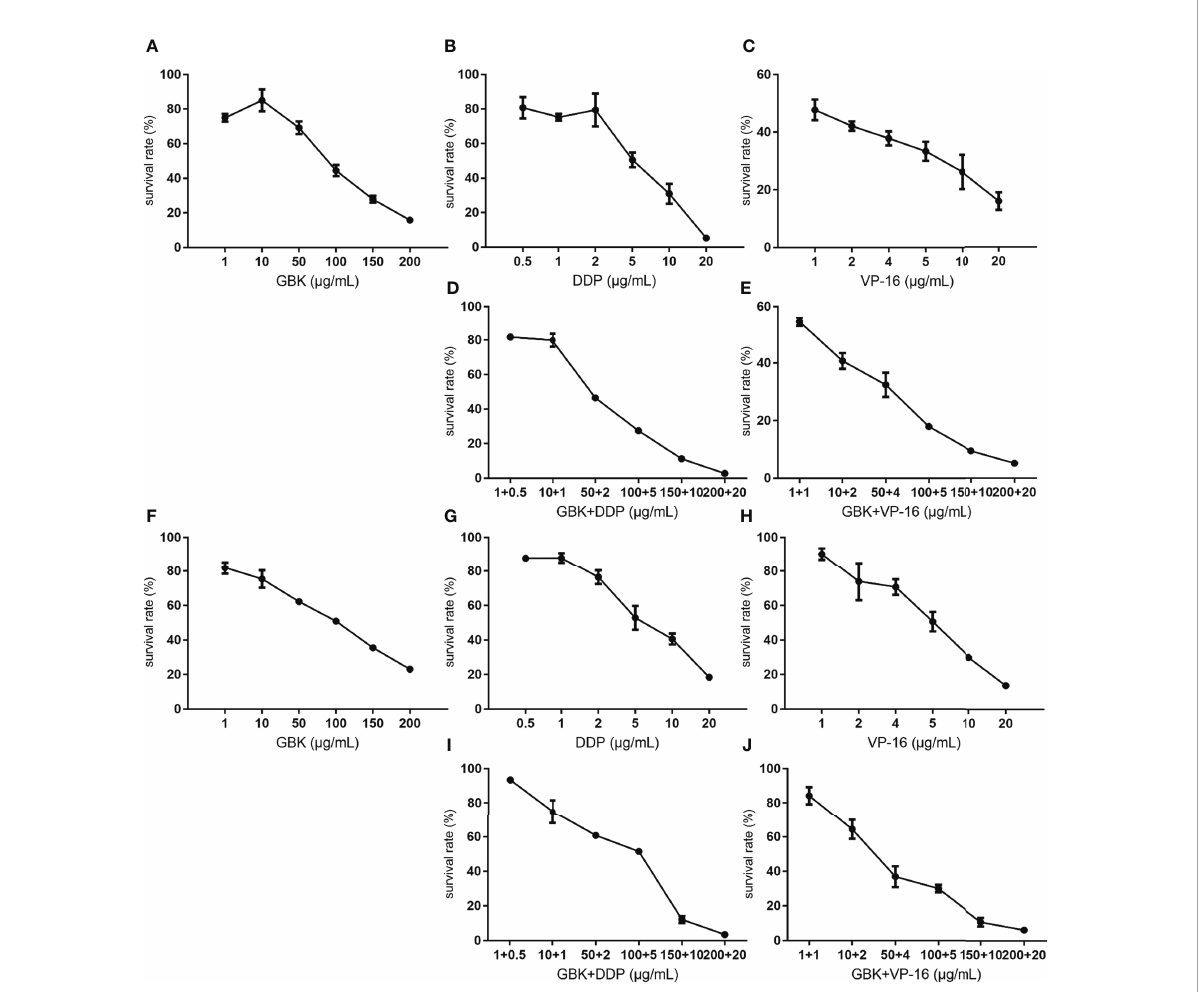
FIGURE 5 Combination treatment with GBK and DDP/VP-16 has synergistic and dose reduction potential in the proliferation of breast cancer cells. The growth inhibition assay was carried out using CCK-8 Kit, and the cell survival rate was measured 48 hours after drug administration. The sensitivity of SUM-159 and MCF-7 cell lines to growth inhibition 48 hours after exposure to GBK and DDP/VP-16 (IC50 concentrations for DDP/VP-16 was 5 m g/ml) was determined. The survival rate of SUM-159 cells under different concentrations of (A) GBK, (B) DDP, (C) VP-16, (D) DDP and GBK, (E) VP-16 and GBK is showed in the top panel. The survival rate of MCF-7 cells under different concentrations of (F) GBK, (G) DDP, (H) VP-16, (I) DDP and GBK, (J) VP-16 and GBK is showed in the bottom panel. Data are presented as mean ± s.e.m. of three independent